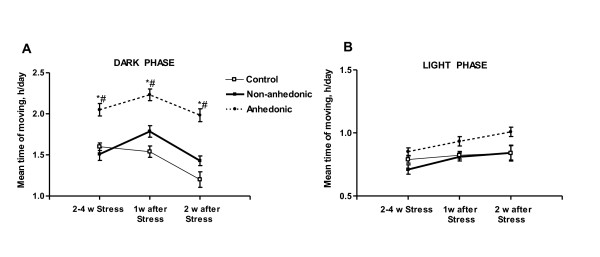
Anhedonic mice display lasting increases in home cage activity during the dark phase of the day. (A) During the dark phase of the diurnal cycle, mean time of horizontal movement of the anhedonic group (dashed line) is significantly elevated during 2nd-4th weeks of stress, and during weeks 1 and 2 after the termination of the stress procedure, as compared to the non-anhedonic (plain thick line) and control (plain thin line) groups (*p < 0.05 vs. control group and # p < 0.05 vs. non-anhedonic group; Mann-Whitney). This parameter does not change in the non-anhedonic group throughout the entire experiment (p > 0.05 vs. control group). (B) During the light phase of the day, no difference between the groups in home cage activity is observed (p > 0.05). Data are expressed as mean ± (SEM).